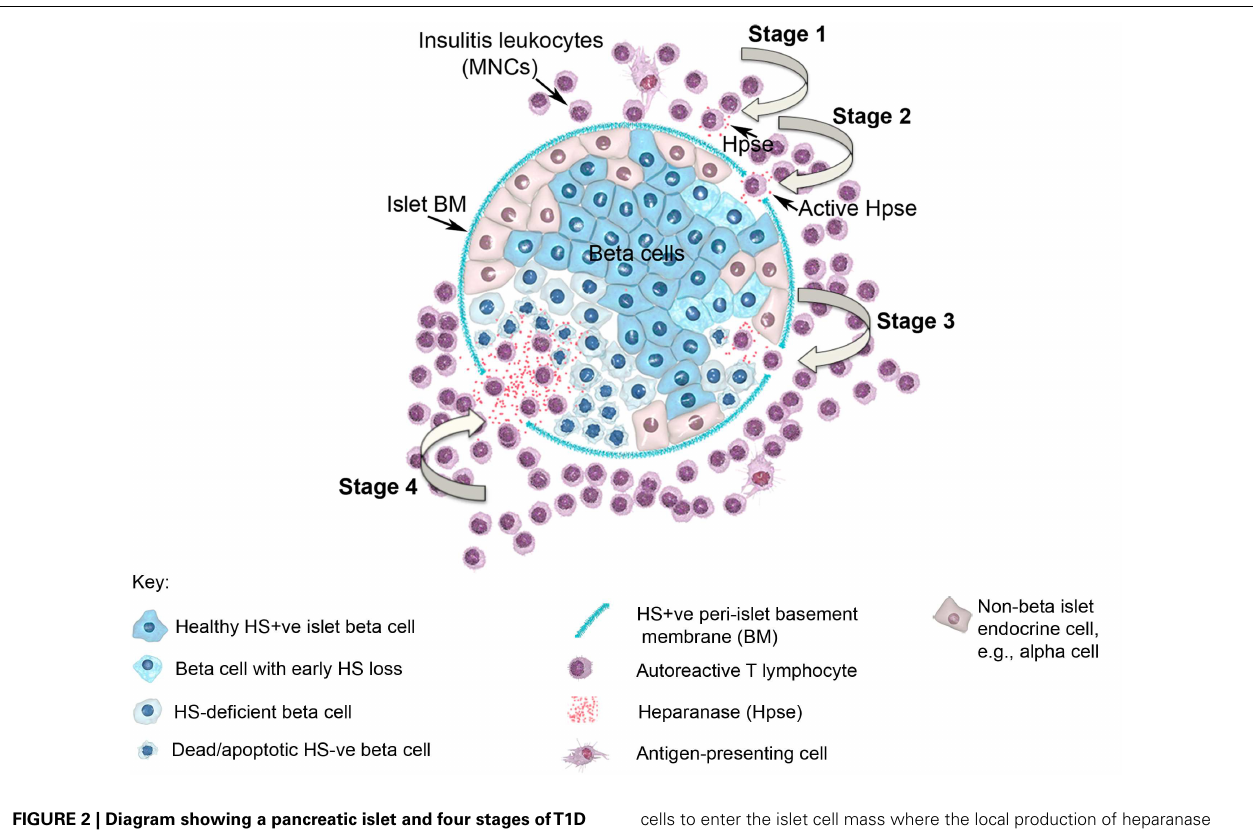
FIGURE 2 | Diagram showing a pancreatic islet and four stages ofT1D disease driven by heparanase and loss of intra-islet HS . HS (intense blue color) is shown in normal beta cells and in intact peri-islet BM. In Stage 1 of the disease process, non-destructive insulitis mononuclear cells produce heparanase (red dots). Onset of destructive insulitis occurs when heparanase becomes catalytically active and degrades HS in the islet BM (Stage 2). Damage to the islet BM barrier allows activated autoreactiveT